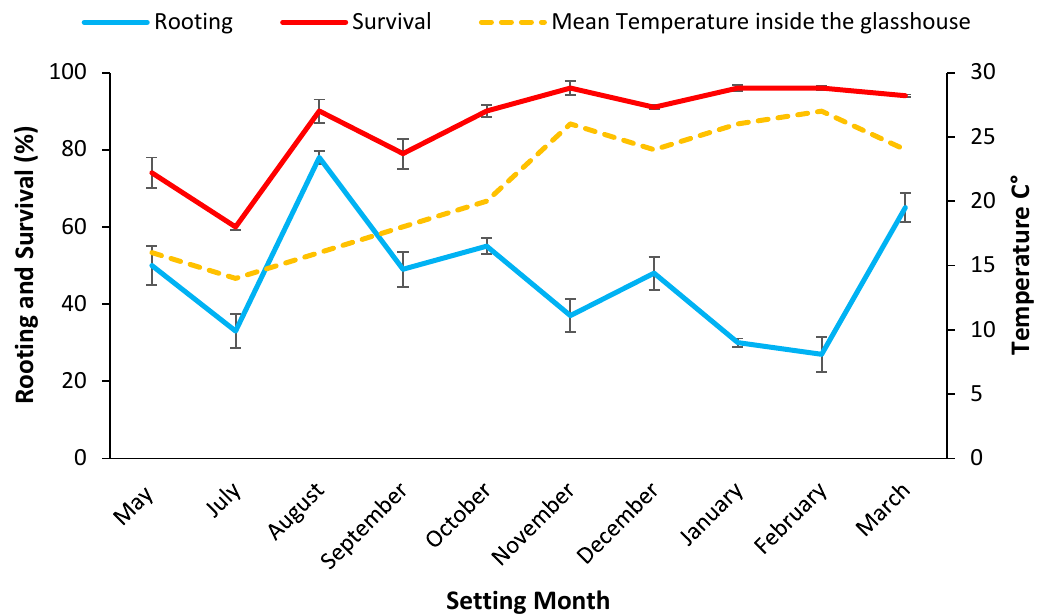
Figure 2. Setting date means (i.e., data pooled over densities) for rooting rate % 28 days post setting and survival rate % 84 days post setting for mini cuttings from stock plants grown in potting mix plotted with the mean temperature inside the glasshouse during the setting months. Bars represent SE.